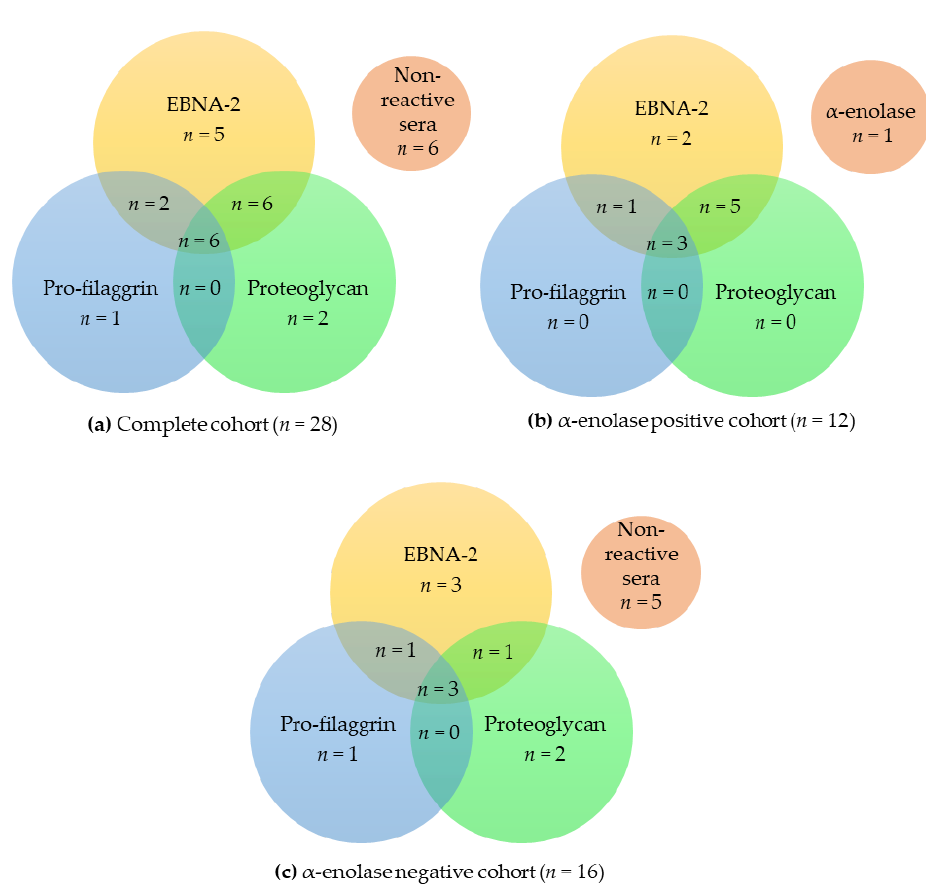
Figure 4. Venn diagram illustrating overlapping anti-citrullinated protein antibody reactivities to EBNA-2, pro-filaggrin and proteoglycan. ( a ) Reactivities of the complete rheumatoid arthritis (RA) cohort to the selected peptides ( n = 28). ( b ) Reactivities of α -enolase-positive RA serum samples ( n = 12). ( c ) Reactivities of α -enolase-negative RA serum samples ( n = 16).